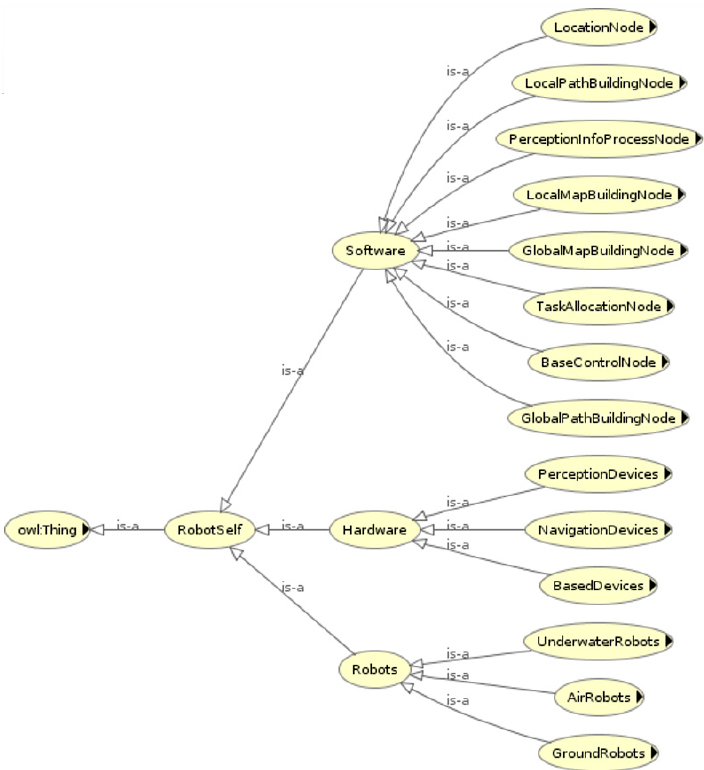
Figure 5. The robot ontology shown in Protégé.